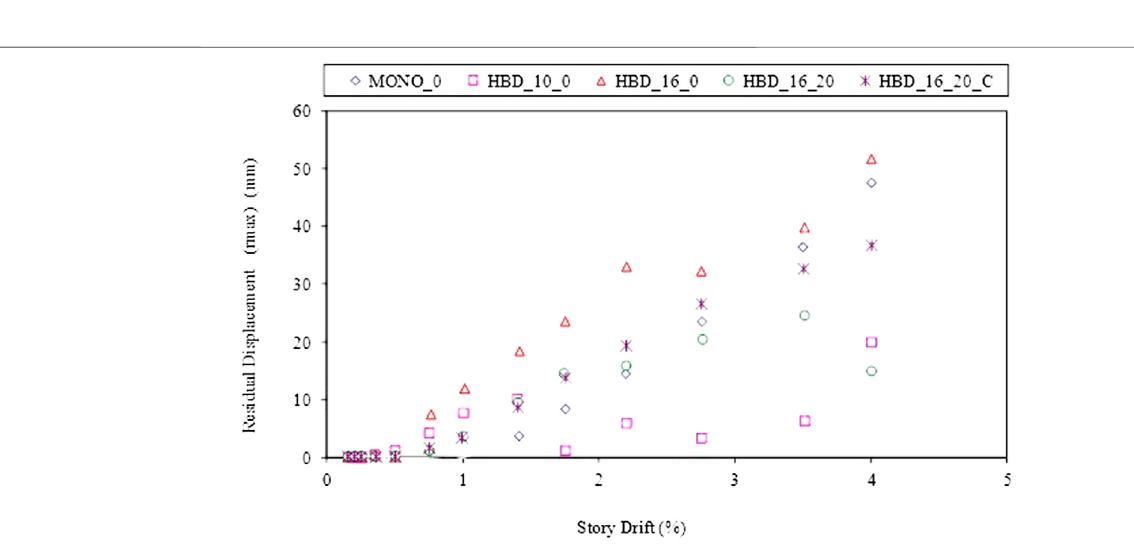
FIGURE 14 | Residual displacements at the specimens depending on the story